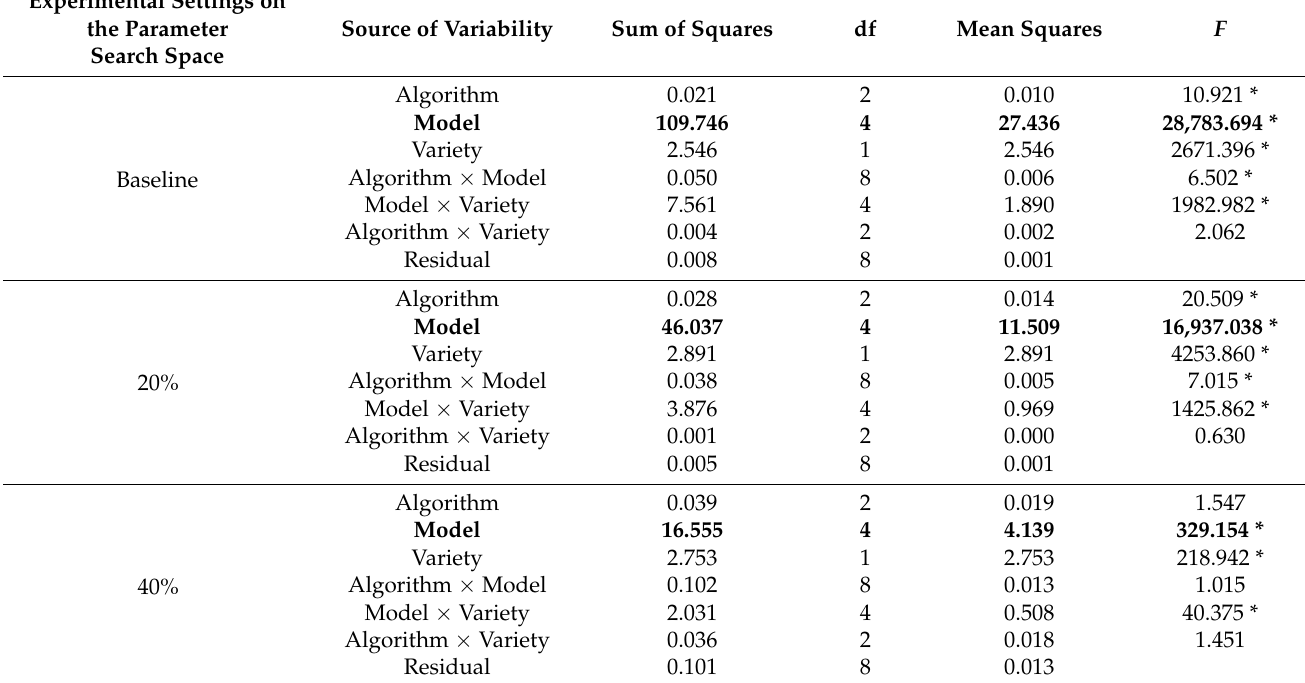
Table 4. Analysis of Variance (ANOVA) for RMSE computed between observations and simulations (with the optimal parameters) from different combinations of optimization algorithms, phenology models and grapevine varieties. ANOVA is conducted under different settings of parameter search space. Asterisks indicate the statistical significance of F statistics at p < 0.01 (df: degree of freedom). The main source of variance is highlighted in bold for each experimental setting. The results for intercept are not shown. Note computation of all statistics (e.g., F value) is based on the full numeric precision, but numbers are all rounded to only three decimal digits for simplicity in this